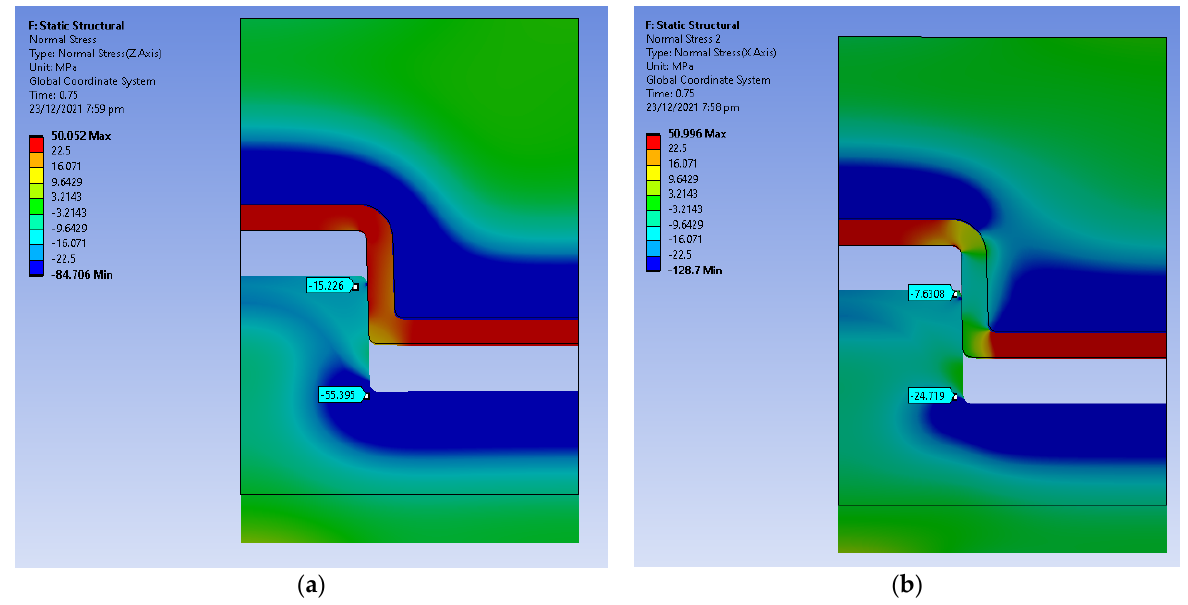
Figure 16. ( a ) Hoop Stress at 0.75 s (3 mm displacement); ( b ) Radial Stress at 0.75 s (3 mm displace- ment).